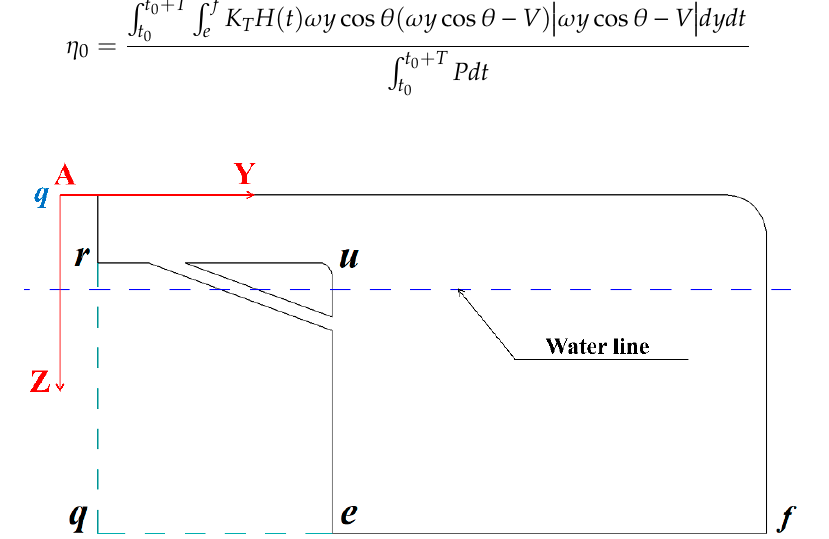
Figure 6. The shape of the paddle in the stroke mechanism. The blue line is the water line when the paddle is immerged into the water.